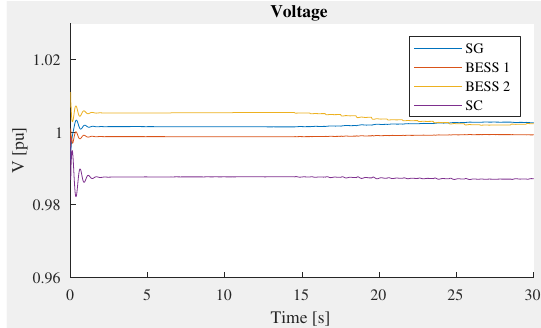
Figure 16. Voltage.